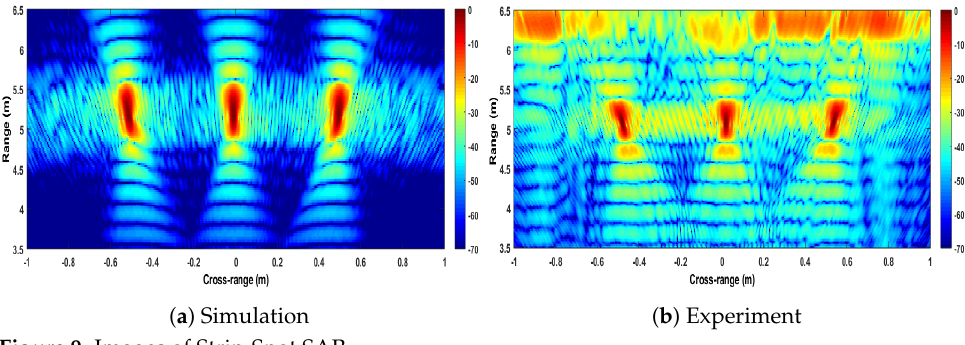
Figure 9. Images of Strip-Spot SAR.